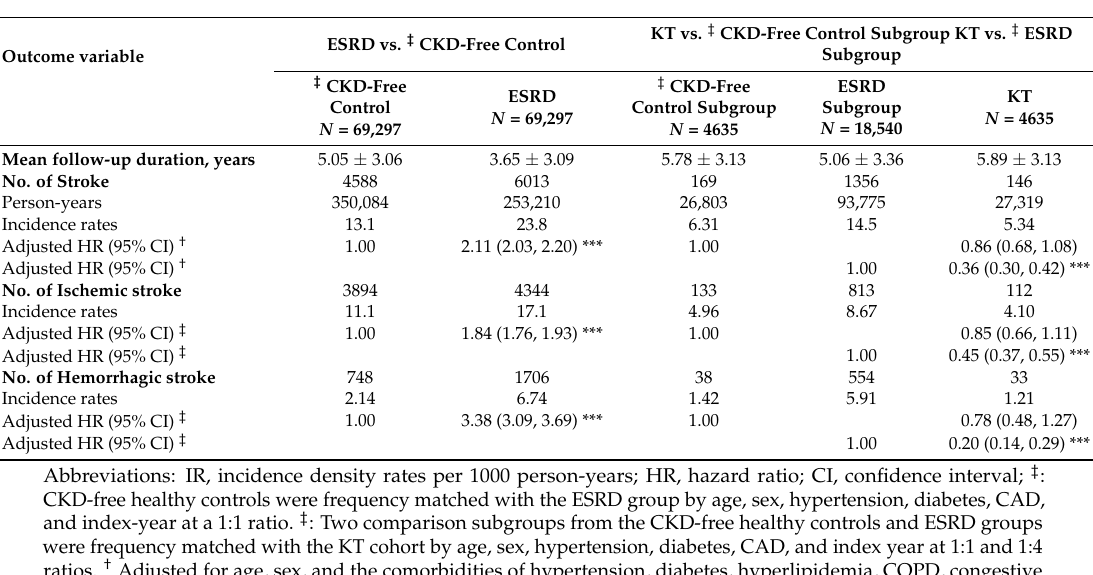
Table 2. Crude and adjusted hazard ratios for stroke in the ESRD, KT, and control groups.